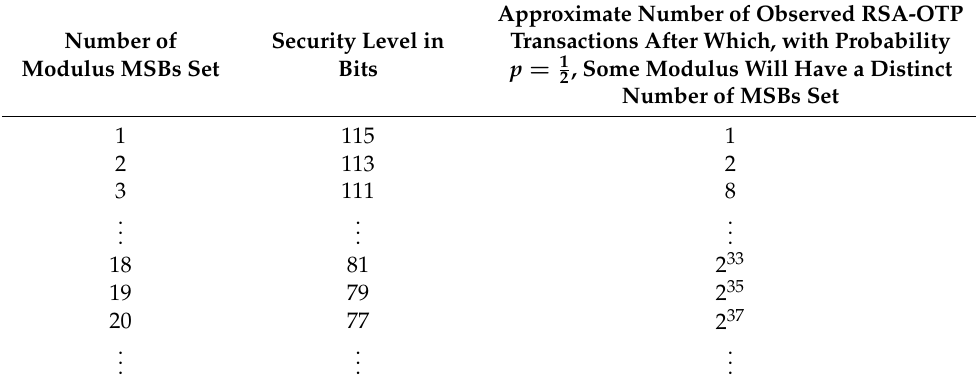
Table 1. Summary of RSA-OTP moduli security as a function of the number of known most significant bits (MSBs) of 128-bit moduli. Approximate Number of Observed RSA-OTP Transactions After Which, with Probability Number of Security Level in p = 1 Modulus MSBs Set Bits , Some Modulus Will Have a Distinct 2 Number of MSBs